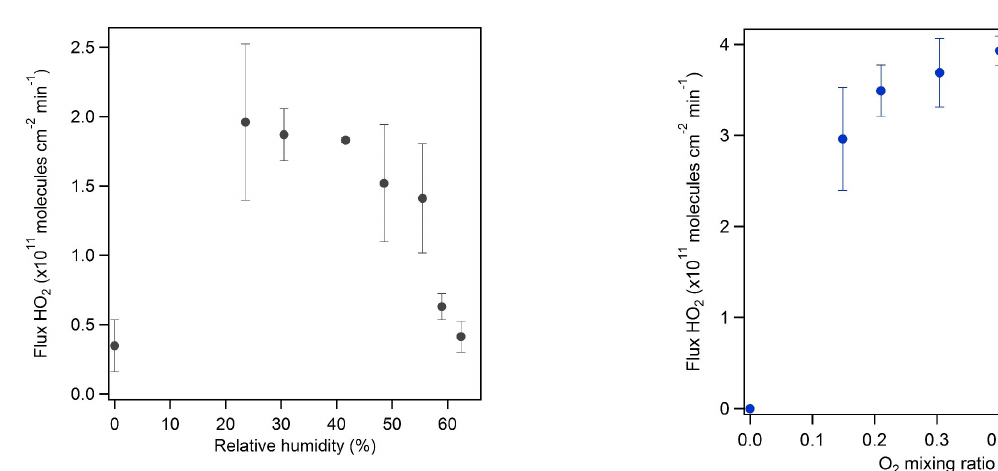
Figure 6. The flux of HO 2 in moleculescm − 2 min − 1 , measured by NO loss, above a film composed of IC and CA normalized to the film surface area as a function of the O 2 mixing